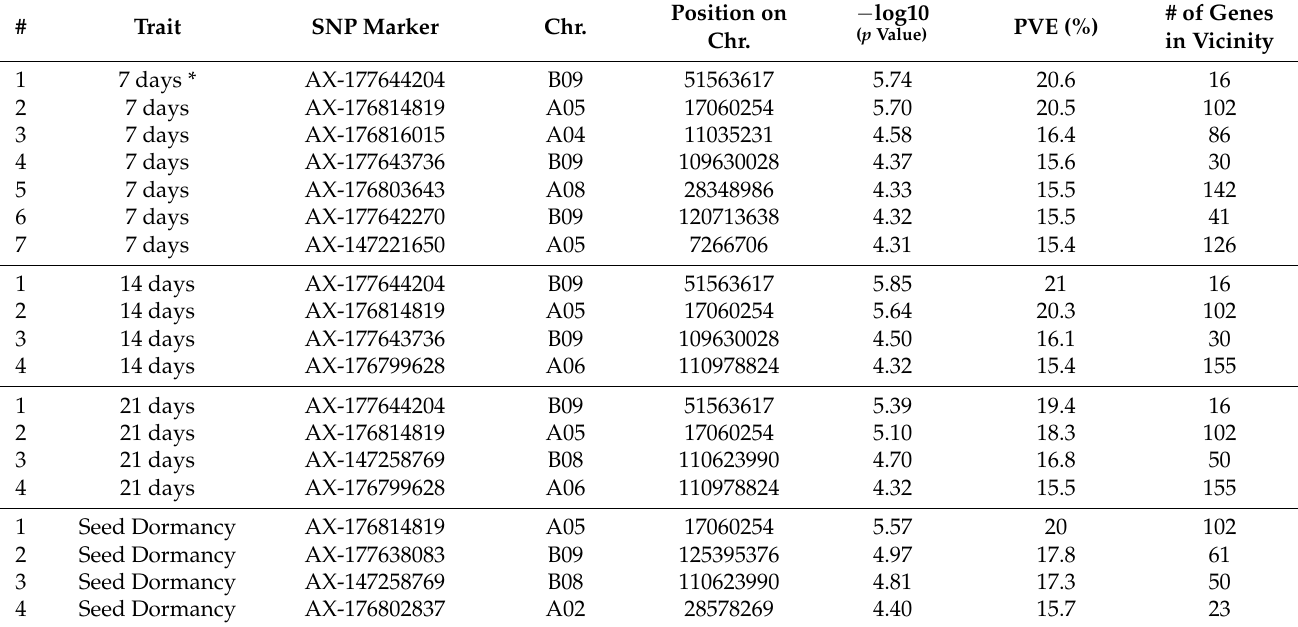
Table 4. Significant markers associated with seed germination at a different time intervals and seed